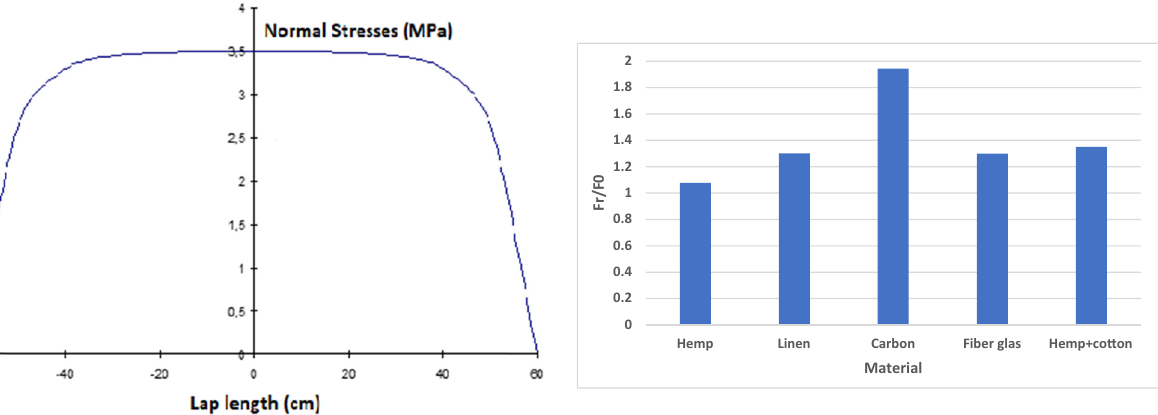
Figure 8: In fl uence of material type on ultimate load in the fl exion